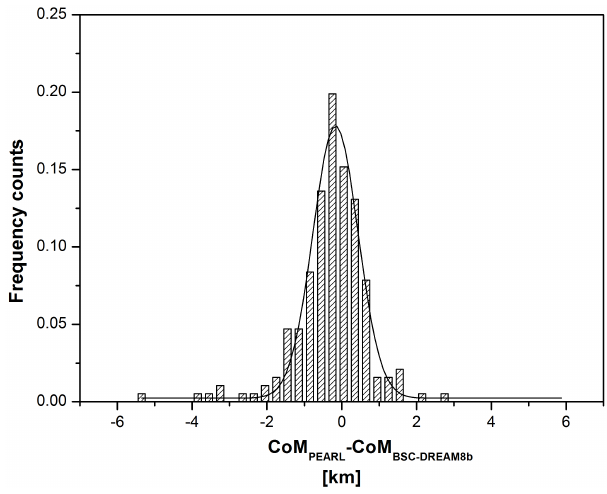
Figure 2. Distribution of the difference of the dust layer CoM as measured by PEARL and evaluated from the BSC-DREAM8b